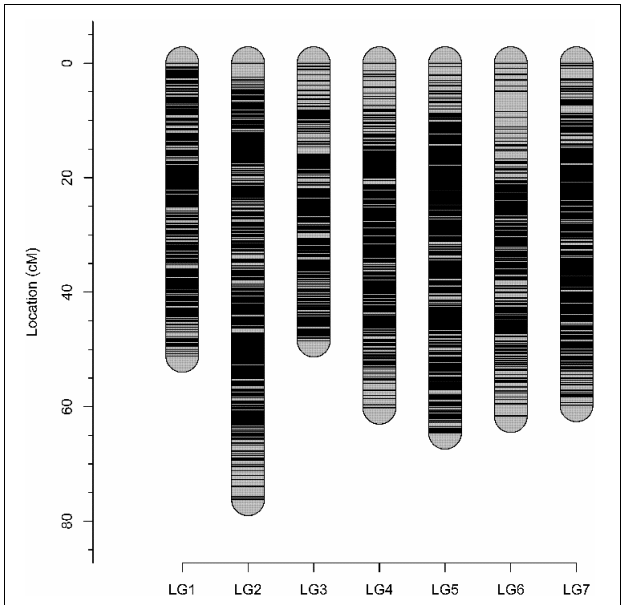
FIGURE 1 | Visual representation of the ‘Morden Blush’ × Brite Eyes TM integrated consensus